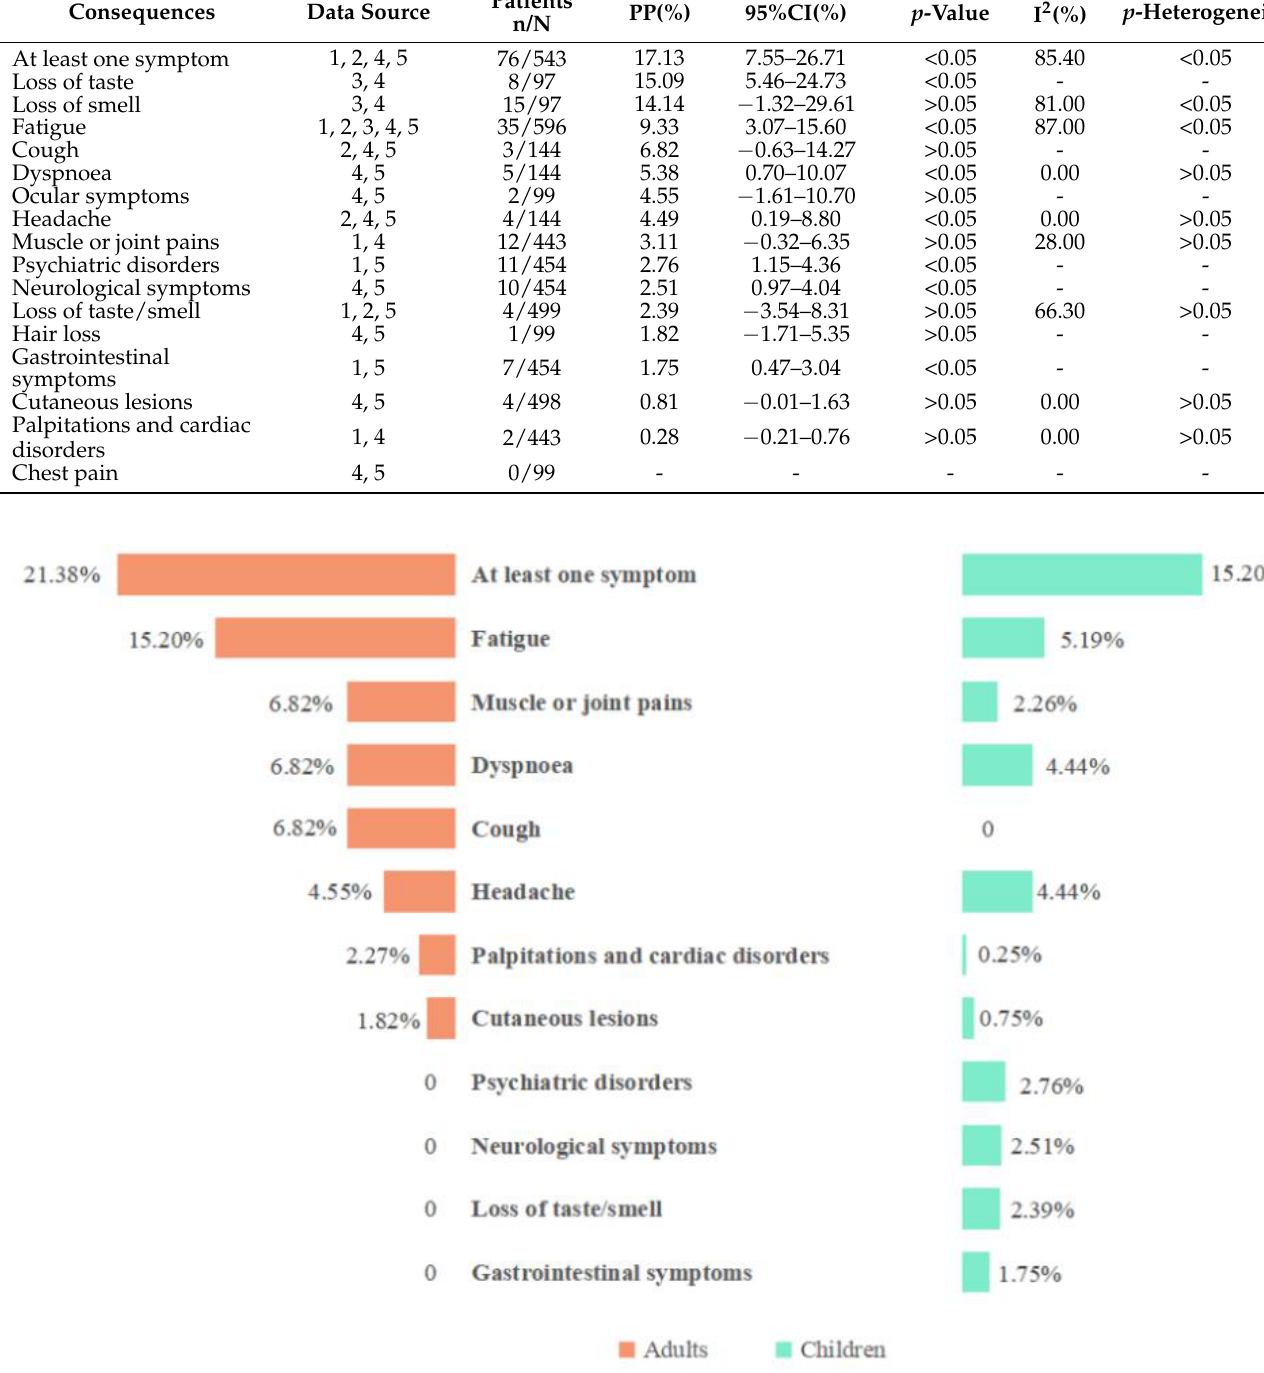
Figure 2. Comparison of pooled prevalence (PP) of long-term consequences of asymptomatic SARS- CoV-2 infection among adults and children.